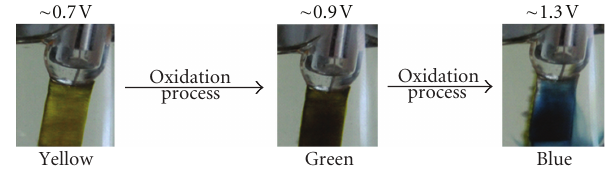
Figure 6: The colour changes by electrooxidation of AnPS in acidic aqueous